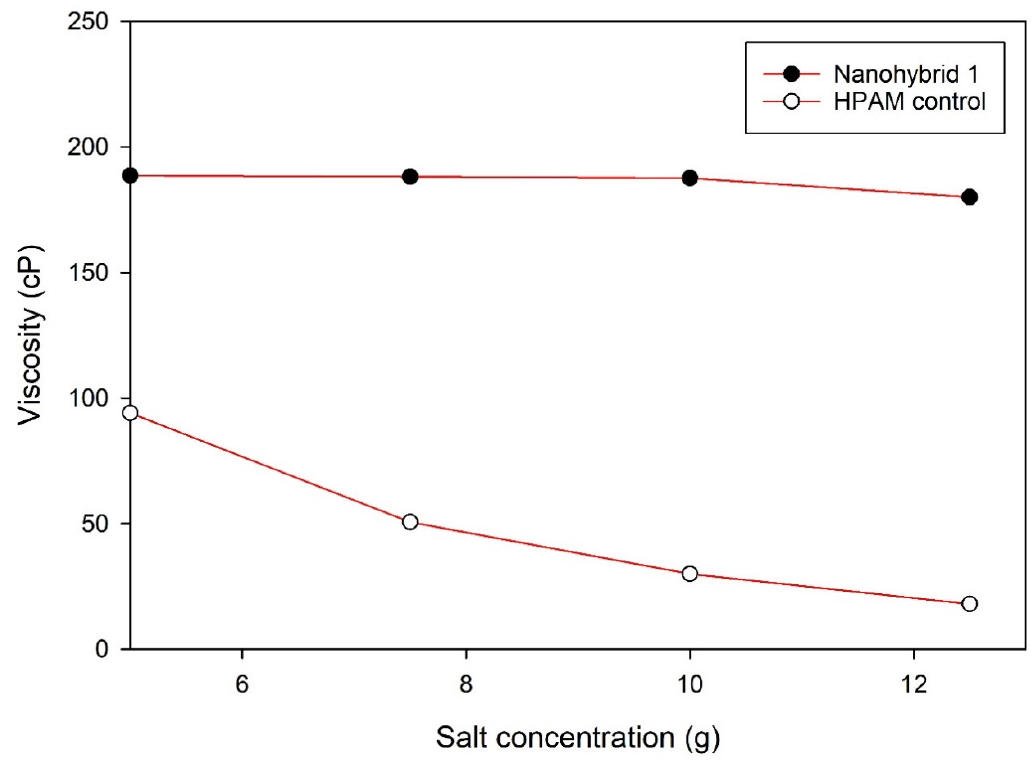
Figure 9. E ff ect of the salt concentration on nanohybrid 1 and HPAM polymer solution. Figure 9. Effect of the salt concentration on nanohybrid 1 and HPAM polymer solution. Shear rate = Shear rate = 10 s − 1 , T = 85 ◦ 10 s − 1 , T = 85 °C.